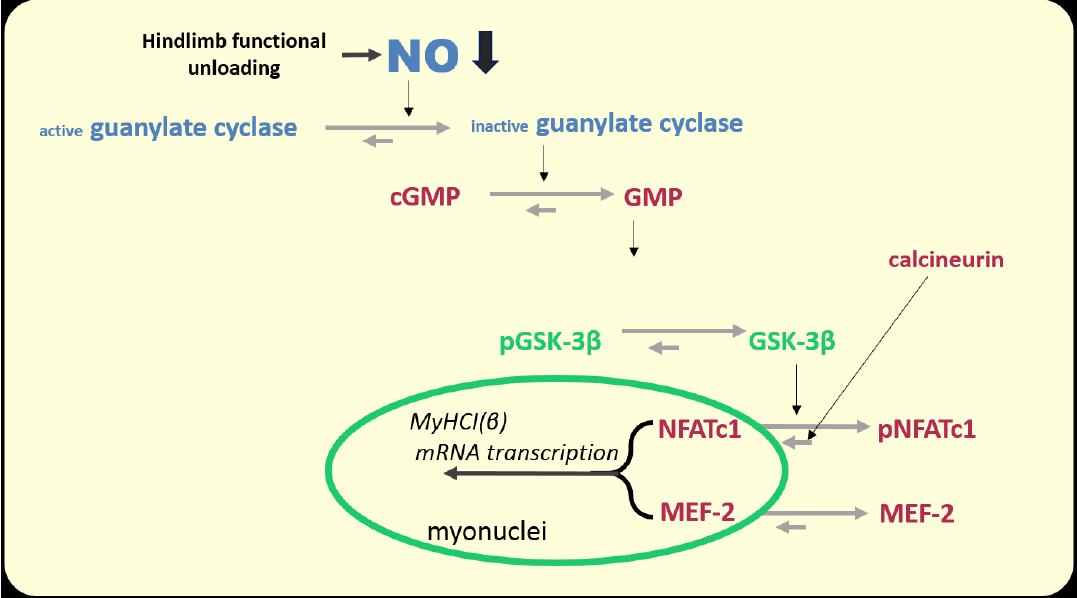
Figure 8. NO-dependent role of GSK-3β in the regulation of nuclear-cytoplasmic traffic of NFATc1 and expression of the slow isoform of the MyHC gene (hypothesis). Rat hindlimb unloading leads to a decrease in NO levels in the soleus muscle, which results in cGMP-dependent GSK-3β dephosphorylation and activation. GSK-3β phosphorylates NFATc1 causing NFATc1 nuclear export, which leads to a decrease in the expression of the slow MyHC gene.